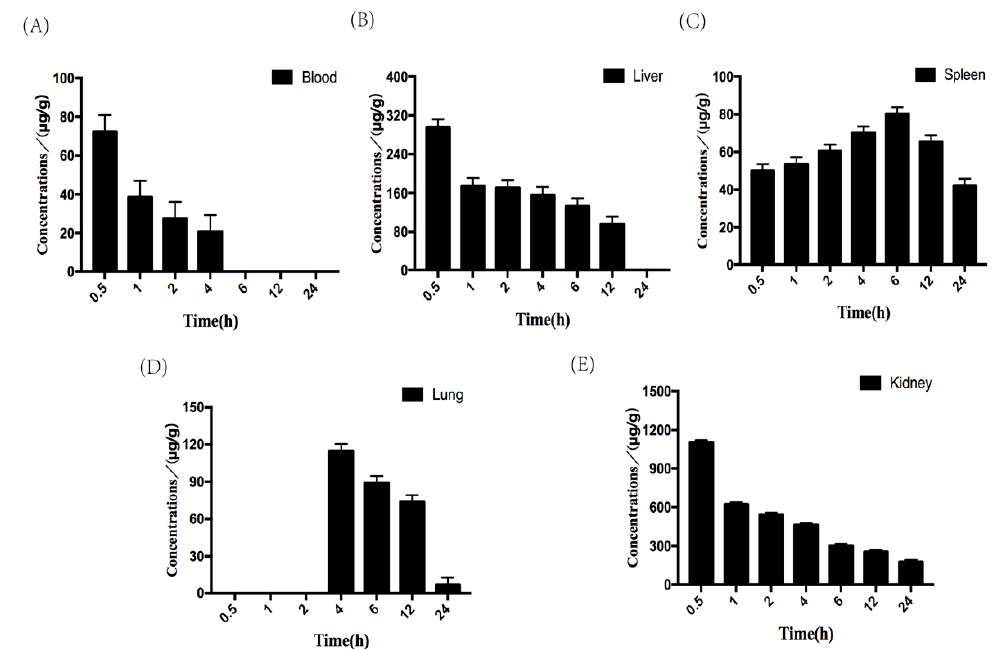
Figure 5. Tissue distribution of FITC-fucoidan in mice. ( A ) Concentrations of FITC-fucoidan in blood ( µ g / g) was expressed as the means ± SD ( n = 5). ( B ) Concentrations of FITC-fucoidan in liver ( µ g / g) was expressed as the means ± SD ( n = 5). ( C ) Concentrations of FITC-fucoidan in spleen ( µ g / g) was expressed as the means ± SD ( n = 5). ( D ) Concentrations of FITC-fucoidan in lung ( µ g / g) was expressed as the means ± SD ( n = 5). ( E ) Concentrations of FITC-fucoidan in kidney ( µ g / g) was expressed as the means ± SD ( n = 5). Table 2. The standard curve of FITC-fucoidan in tissues.